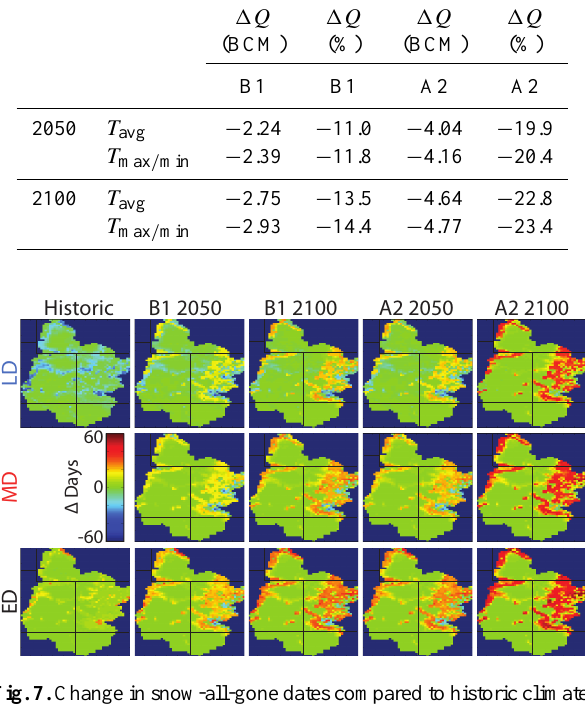
Fig. 7. Change in snow-all-gone dates compared to historic climate, moderate dust (MD) results by grid cell for all dust/albedo scenarios using B1 and A2 emissions scenarios.